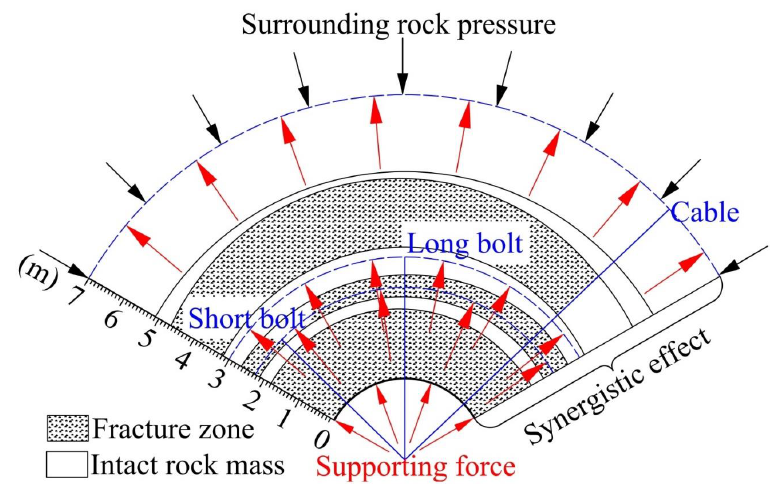
Figure 13. Synergistic effect of the multistage anchorage system.